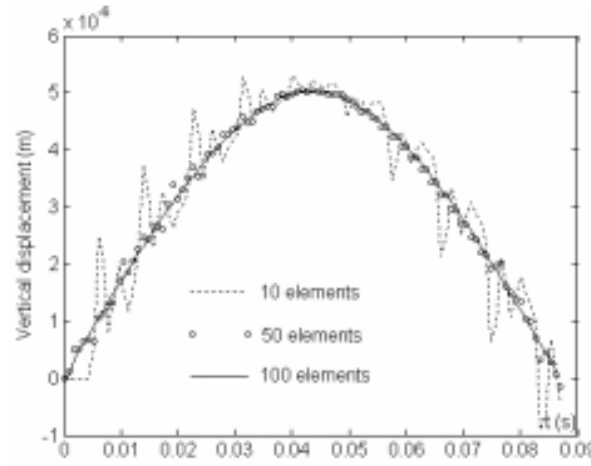
Fig. 6. Time history of dynamic vertical displacement of beam mid-point using DET with various element